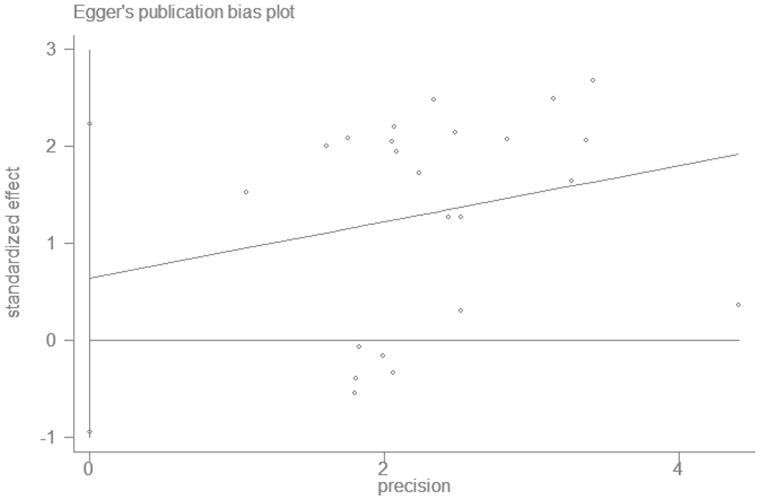
Begg’s funnel plot.